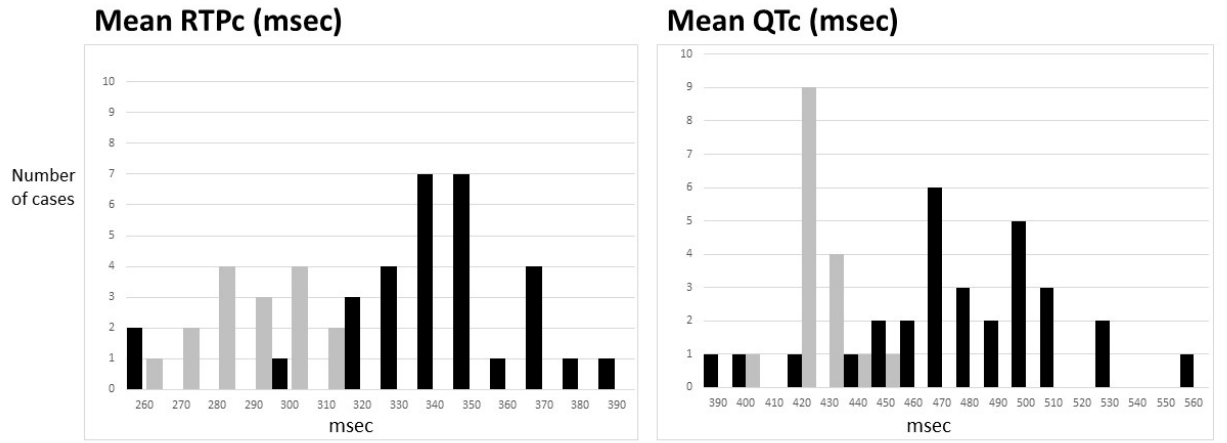
Figure 3. Holter-derived mean QTc and RTPc values are shown from those less than 7 years of age. Normative controls ( n = 16) are shown in grey, and those with long QT syndrome ( n = 31) are shown in black. Values were rounded up or down to the nearest 10 ms.